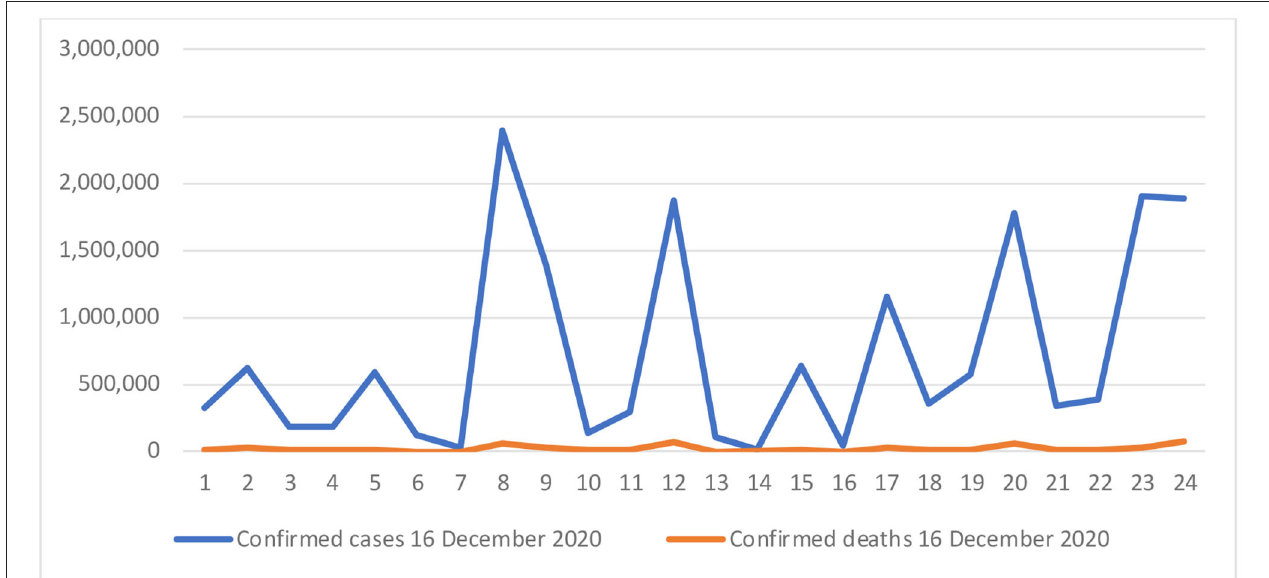
FIGURE 5 | Cases of coronavirus disease 2019 (COVID-19) vs. COVID-19-induced deaths. Source: Author’s